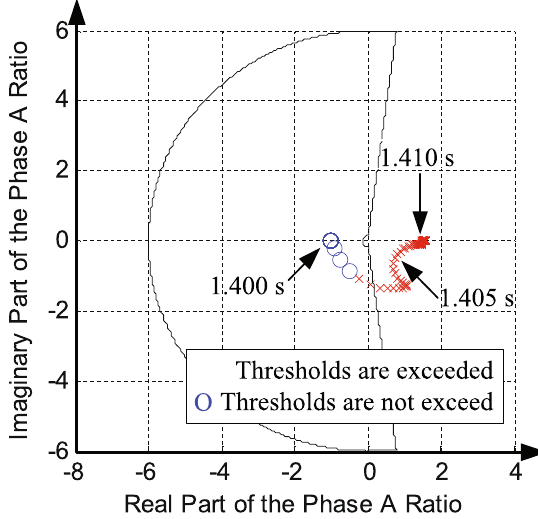
Fig. 18 Calculated current phasor ratio trance of event 4: internal bolted fault, islanded mode